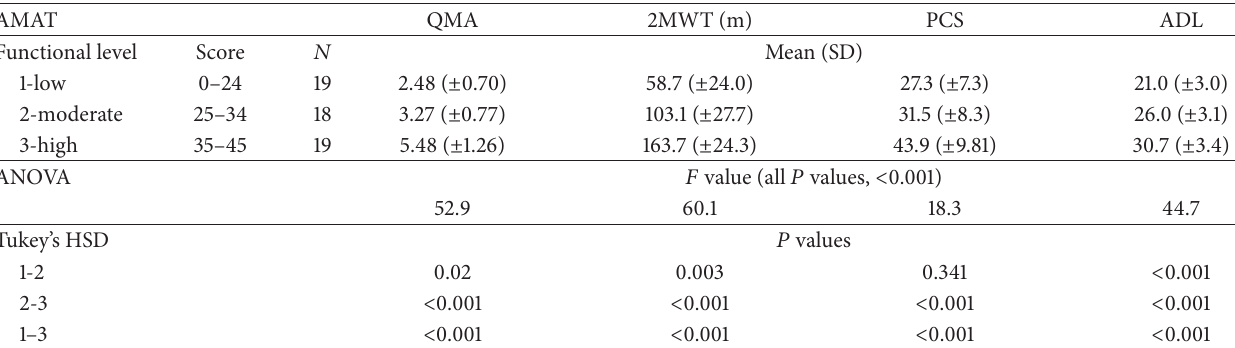
Table 5: AMAT cut scores. Use of AMAT cut scores to discriminate among low, moderate, and high levels of performance across several ICF domains of